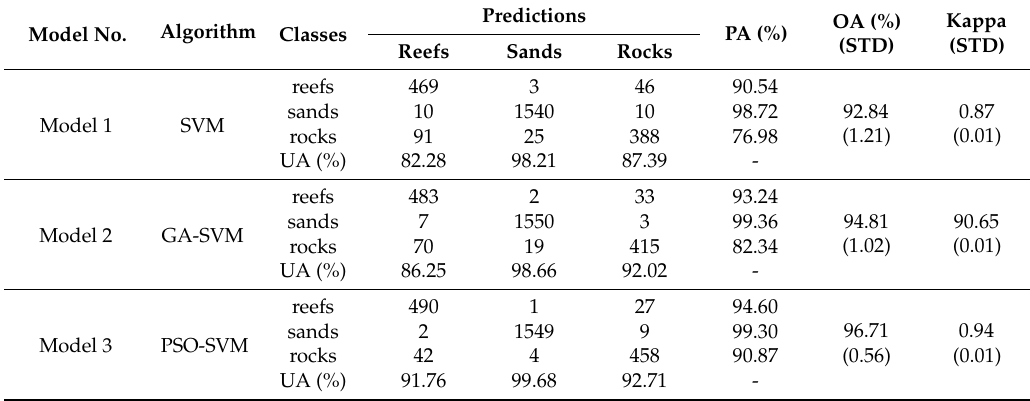
Figure 7. Classification results of different seafloors: ( a ) coverage area of sands and reefs; ( b ) coverage area of sands and rocks; ( c ) coverage area of sands, reefs, and rocks. Magenta represents sands, blue represents reefs, and green represents rocks. Table 5. Evaluation of classification results based on multifeatures.